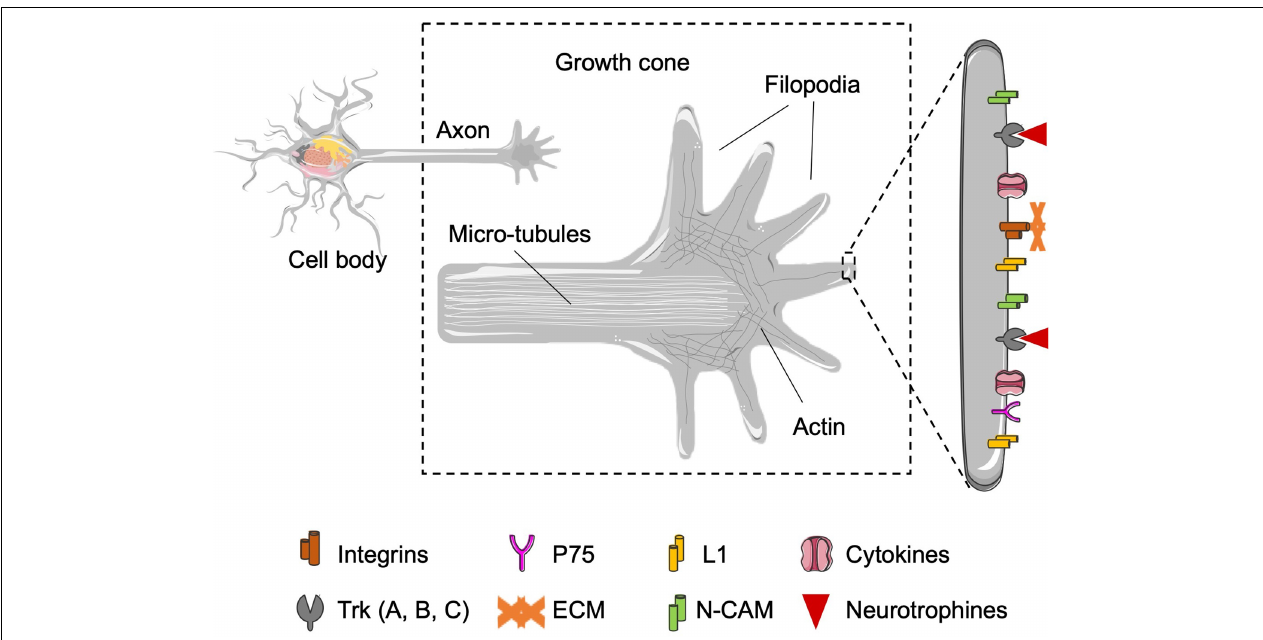
FIGURE 5 | Representation of the growth cone in charge to interact with the Schwann cells and the ECM that surrounds the growing axons. Zoom of growth cone: representation of the growth cone in detail. The organization of the filopodia and the mobile structure in charge of interaction with the physical and chemical environment are supported by actin filaments accumulated in the proximal stump. Zoom of the filopodia: representation of the different molecules expressed in the growth cone. The molecules can be divided in three groups: (i) expression of neurotrophic factors receptors, for neurotrophins (Trk A, B, C, and p75) and neuropoietic cytokines [leukemia inhibitory factor receptor (LIFR), CNTFR ... ]; (ii) cell–cell junction molecules (N-CAM, L1), which will allow the interaction between the regenerating axons and the Schwann cells present in the bands of Büngner, in the distal zone, and (iii) molecules that bind to the ECM (integrins), which will act as a support for axonal guidance to its target